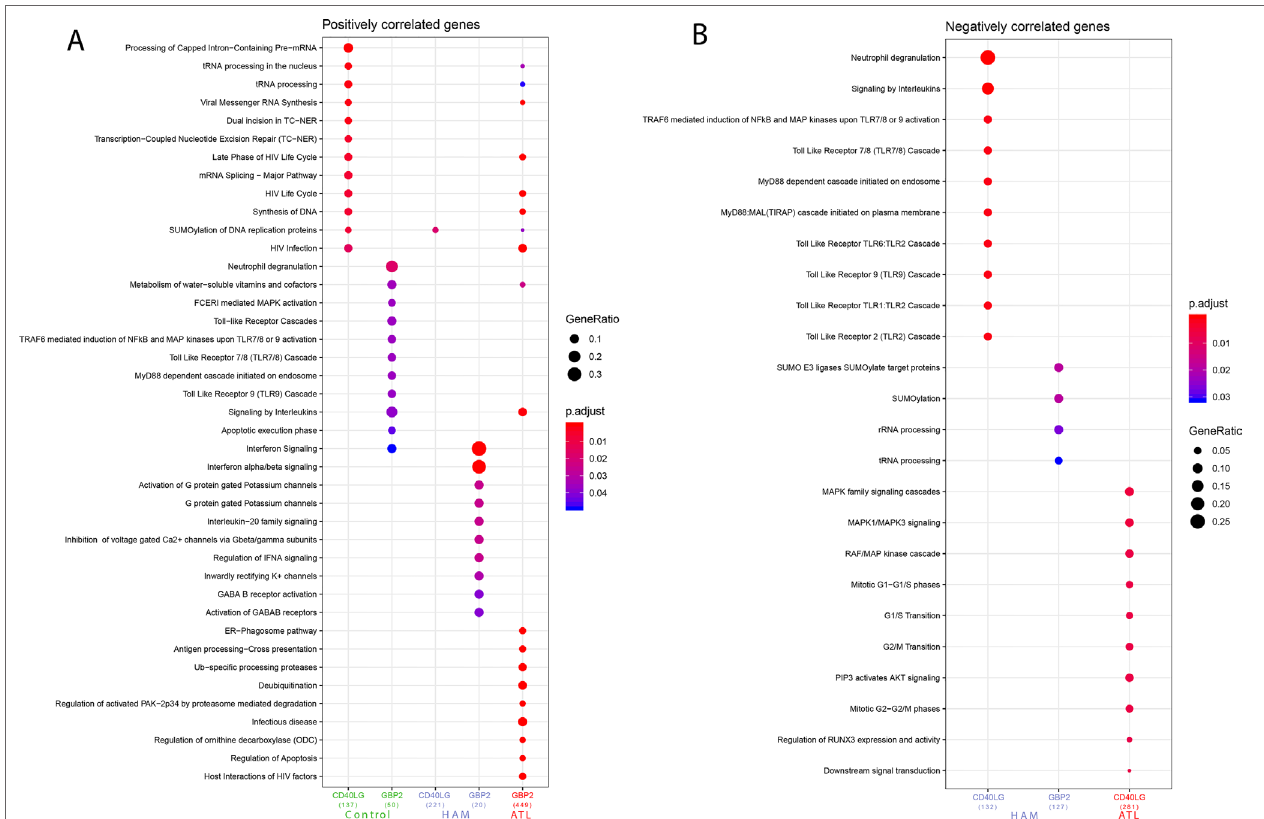
FIGURE 2 | (A) Pathways associated with genes found to be positively correlated with CD40LG and GBP2, grouped according to symptomatology. (B) Pathways associated with genes found to be negatively correlated with CD40LG and GBP2, grouped according to symptomatology. Analysis performed using the following parameters: p-value = 0.05, q-value = 0.2, minimum number of genes to cluster = 20, maximum number of genes to cluster =